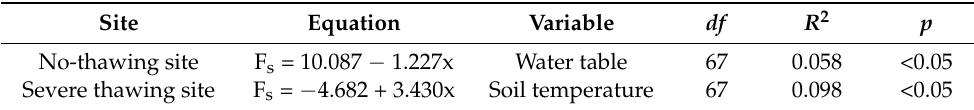
Table 3. Correlations between N 2 O flux and environmental